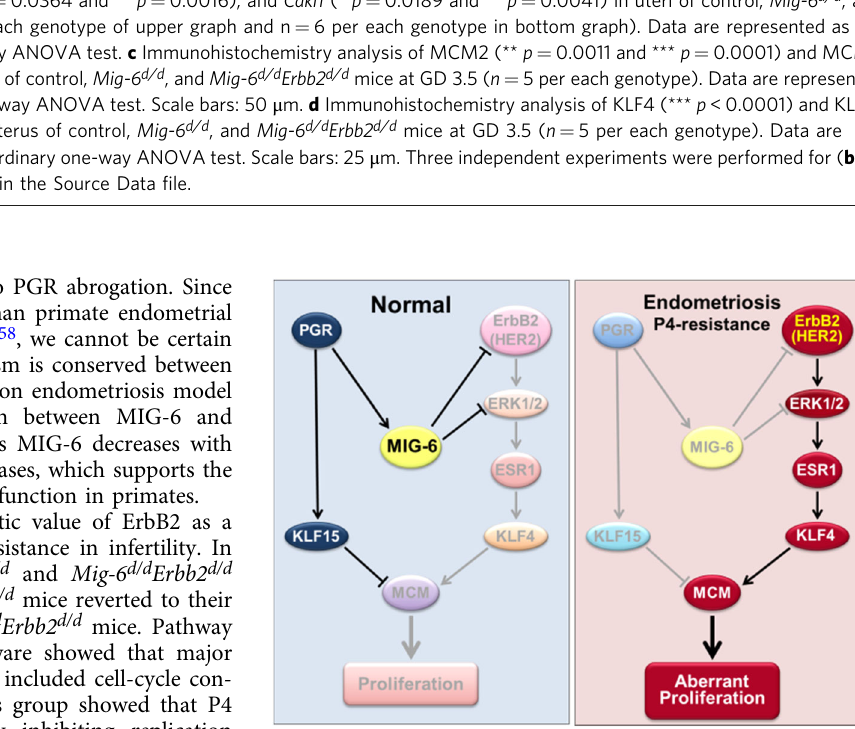
Fig. 7 Recovery of gene expression (Microarray) in Mig-6 d/d mice by Erbb2 double ablation. a Clustering analysis of Mig-6 dependent regulated genes in uteri of control, Mig-6 d/d , and Mig-6 d/d Erbb2 d/d mice at GD 3.5. The extent of gene expression changes is represented by a green-red color scale (green: low expression and red: high expression). b RT-qPCR analysis of transcript amounts of Mig-6 dependent regulated genes, Mcm2 (* p = 0.0108 and *